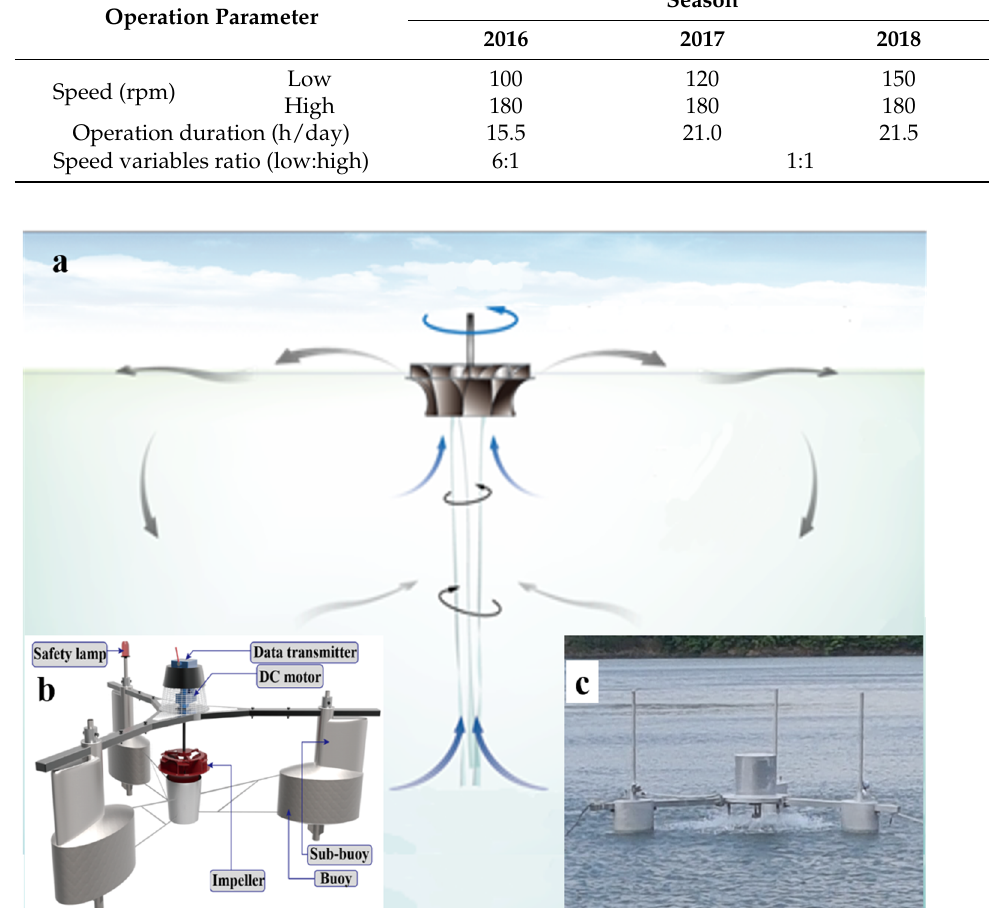
Figure 1. ( a ) Pattern of flow generated from the operation of the convectional water circulation sys- tem (CWCS), ( b ) schematic of the CWCS, and ( c ) depiction of in-field operation.